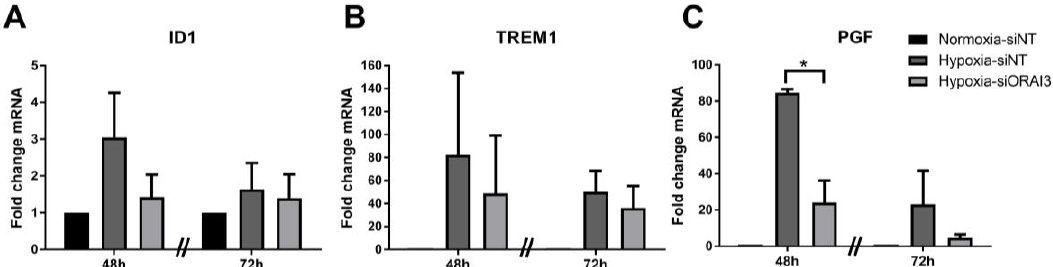
Figure 6. Effect of ORAI3 silencing on the expression of three selected genes from RNA-Seq data that were also up-regulated by hypoxia. Real time RT PCR assessment of the expression of three ORAI3-regulated targets from RNA-Seq that their expression was also up-regulated with hypoxia; ( A ) ID1, ( B ) TREM1 and ( C ) PGF. * p < 0.0001 (one-way ANOVA, with Bonferroni’s multiple comparisons), n = 3, mean ± SD.